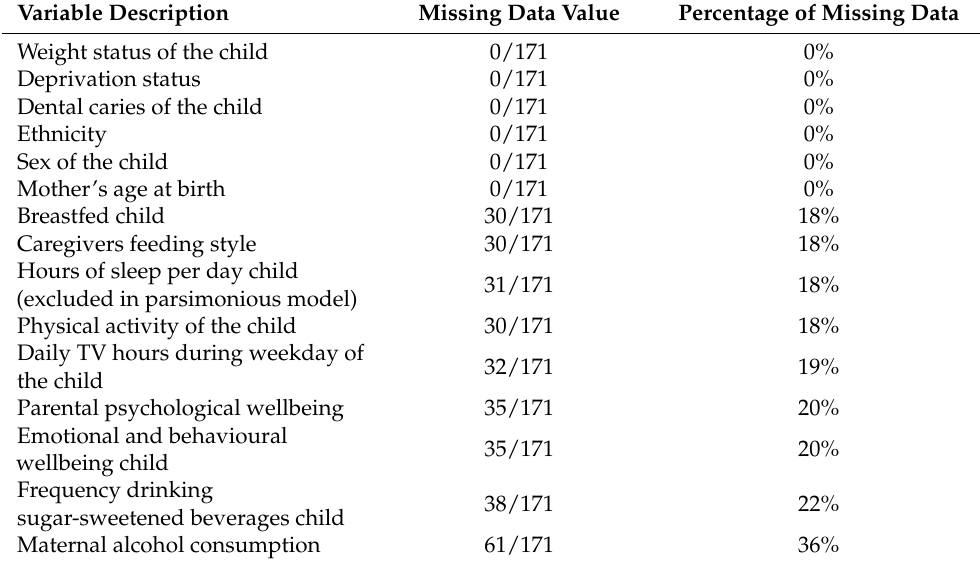
Table A1. Missing